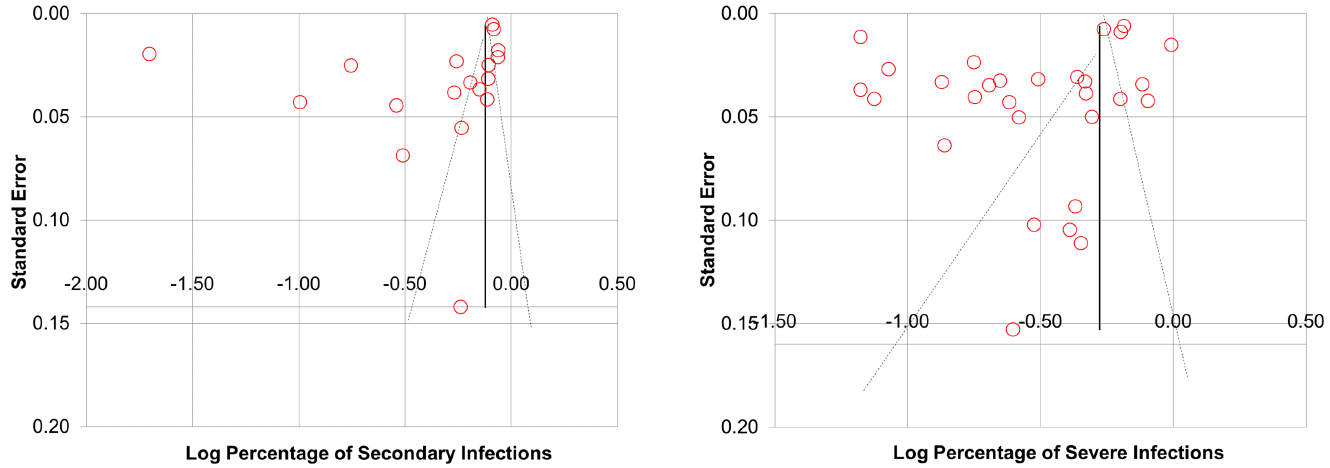
Fig 5. Funnel plot of the percentages of severe infections against standard error and funnel plot of the percentages of secondary infection against standard error. The percentages of severe infections are displayed on a logarithmic scale. The shapes of both the funnel plots revealed obvious